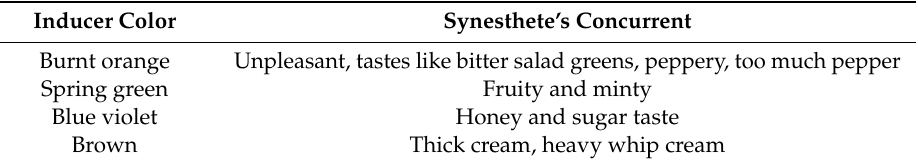
Table 1. Illustrative concurrents.